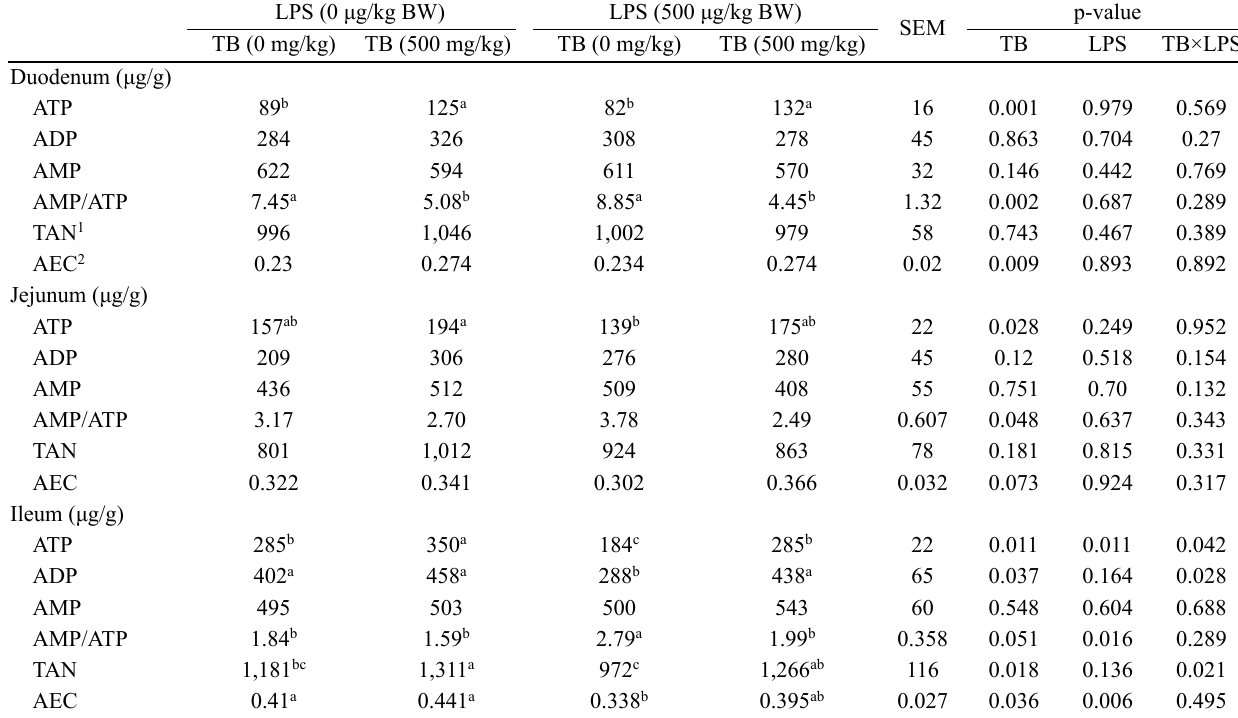
Table 5. Effects of TB on energy status in the small intestine of broilers challenged with